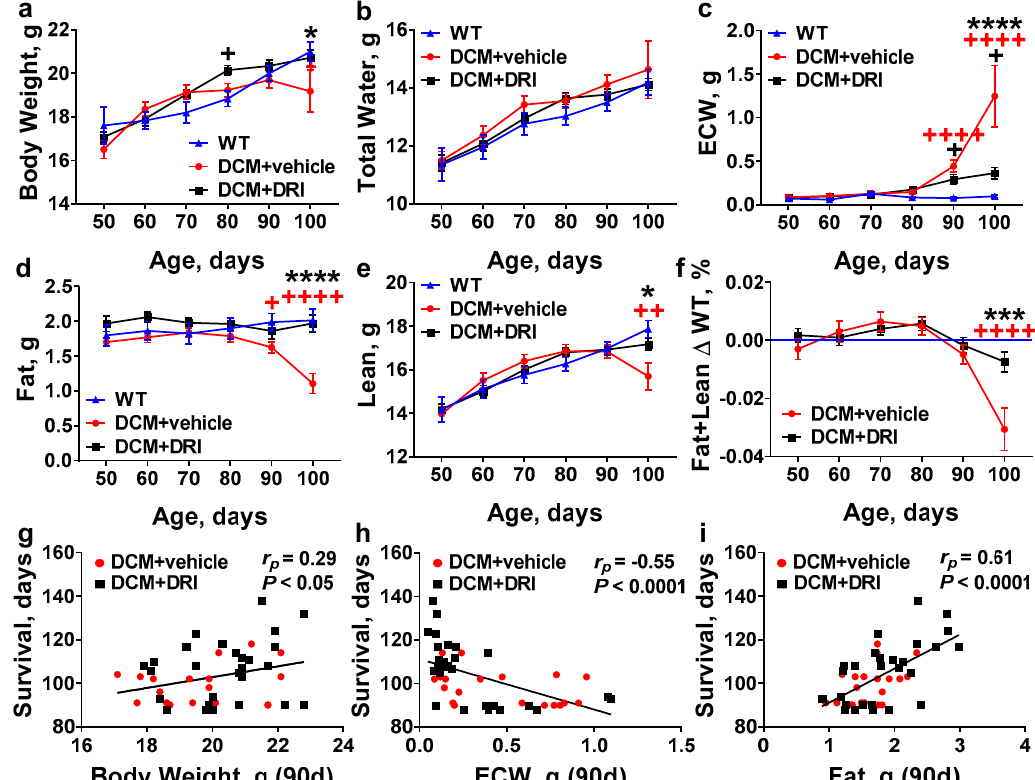
Figure 4. Effects of direct renin inhibition on systemic changes in mouse whole-body composition associated with heart failure progression. Age-related changes in ( a ) body weight, ( b ) total water, ( c ) extracellular water (ECW), ( d ) fat, ( e ) lean mass, and ( f ) combined fat and lean mass in DCM mice with (DCM + DRI) or without renin inhibition (DCM + vehicle) by comparison to wild-type (WT, without DCM) mice. WT ( n = 9–15), DCM + vehicle ( n = 10–27), DCM + DRI ( n = 17–29). ( g – i ) Pearson’s